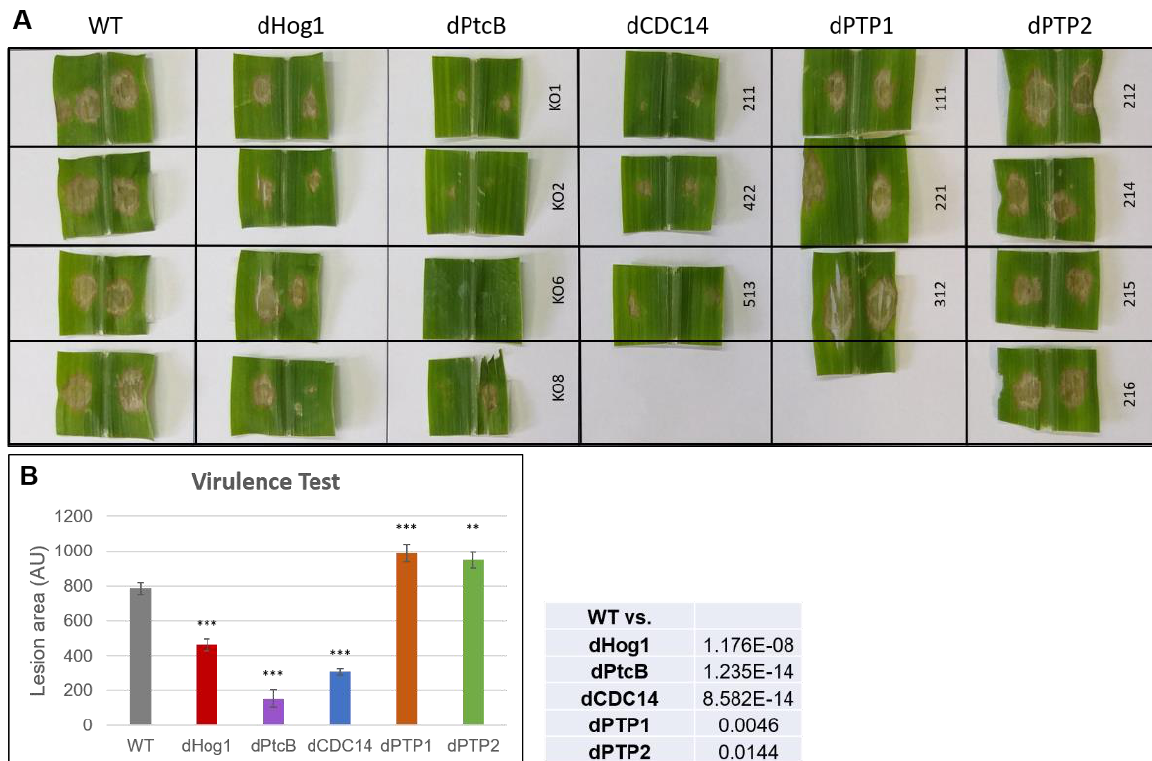
Figure 9. Virulence assay of mutants and WT on maize leaves. ( A ) The third leaf of corn plants (the rounded, juvenile leaf was counted as leaf ‘zero’) was infected with a ~0.09 cm 2 agar block inoculum for 24 h, and was then removed (see Methods). The lesions were measured 4 days from infection. ( B ) Quantitation of the lesion areas. The lesion areas were measured using ImageJ. The graph represents the average lesion area of each strain, calculated from 3 biological repeats for each independent transformant (for the photos of all of the lesions analyzed, see Supplementary Figure S2). The error bars indicate SE. The t -test p -values of each strain vs. the WT were calculated and are marked as follows (inset): p -value < 0.05—**; p -value < 0.01—***.